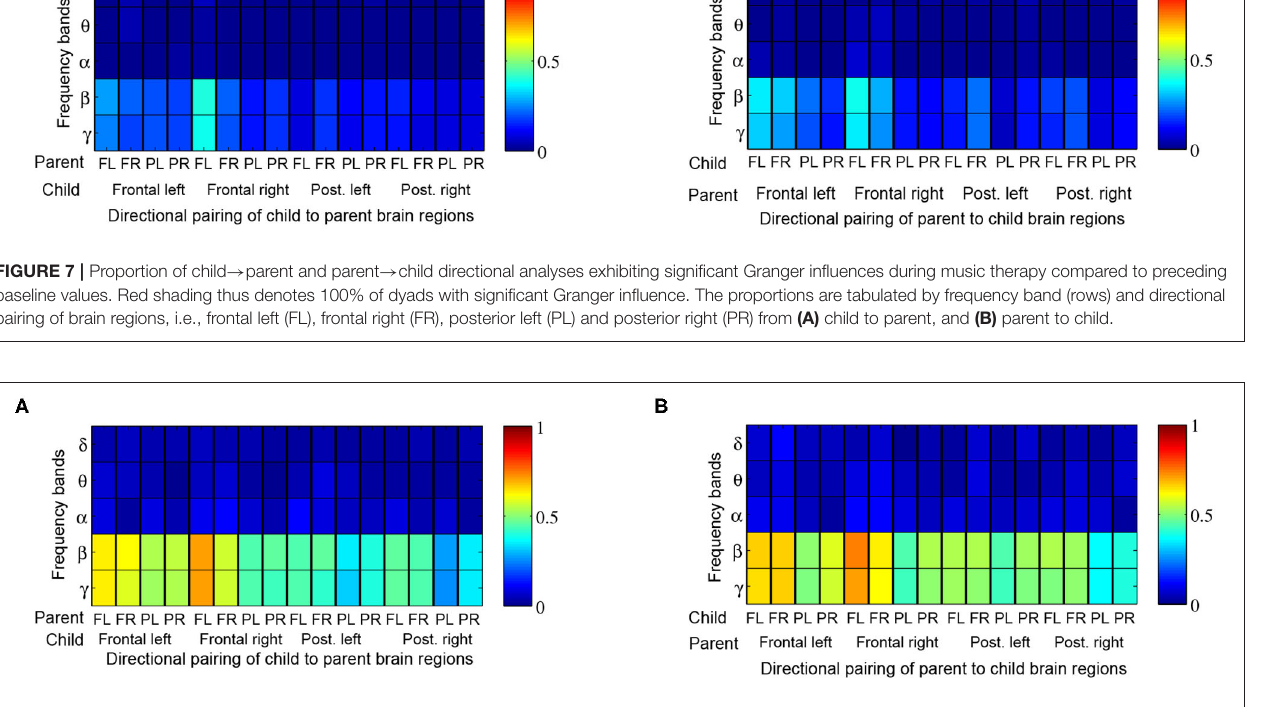
FIGURE 8 | Proportion of child → parent and parent → child directional analyses exhibiting significant increases in Granger influences over the course of a music therapy session. The proportions are tabulated by frequency band (rows) and brain region, i.e., frontal left (FL), frontal right (FR), posterior left (PL), and posterior right (PR) from (A) child to parent, and (B) parent to